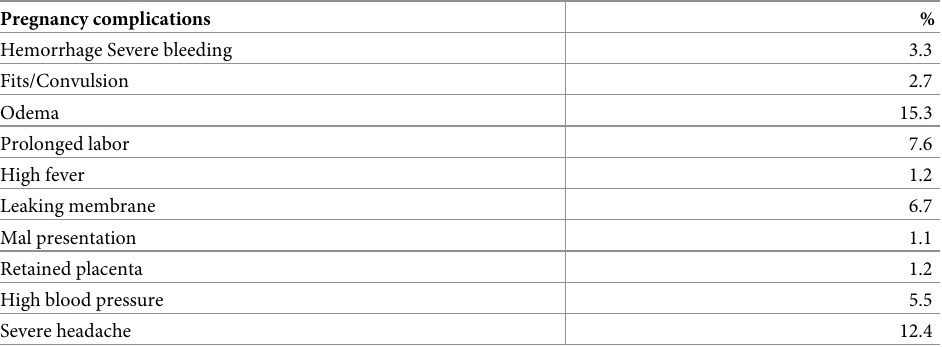
Table 1. Frequency and percentage (%) distributions of pregnancy complications among the urban women (n = 6001) in